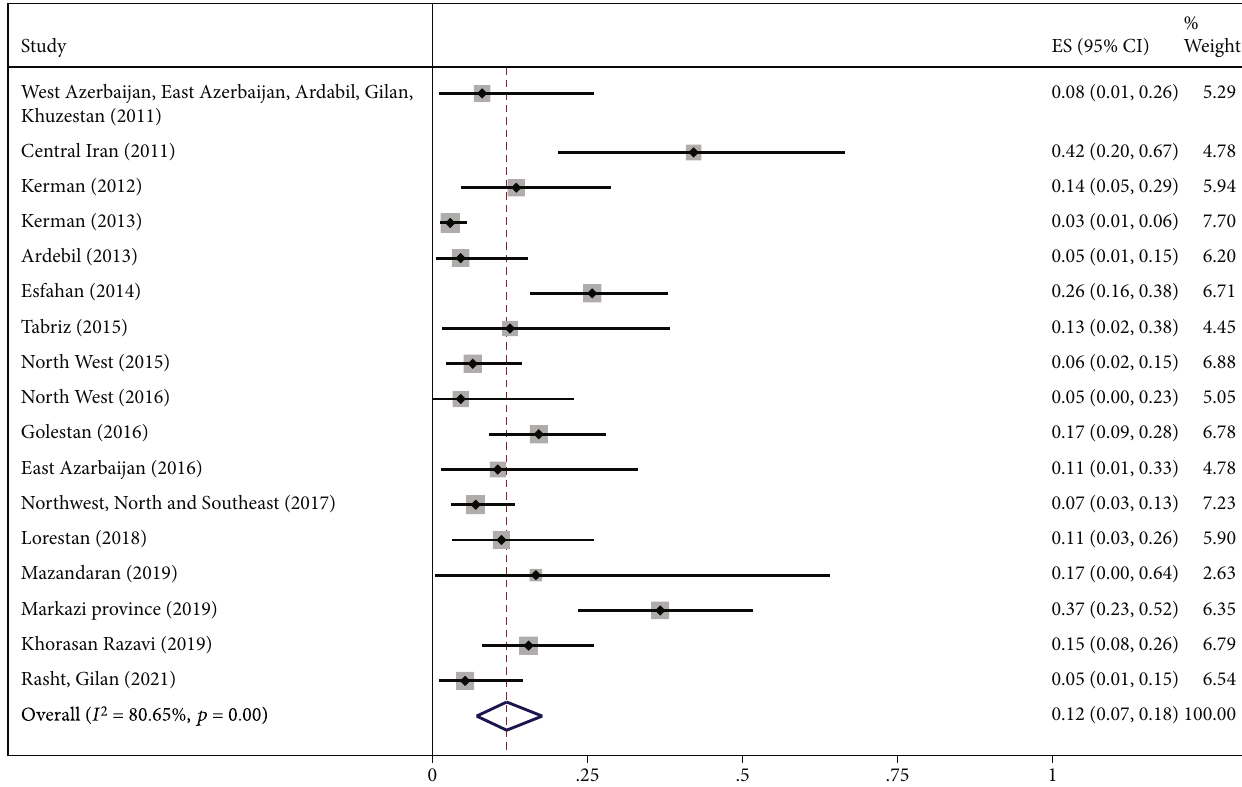
Figure 6: Forest plot of 17 studies on cystic echinococcosis G